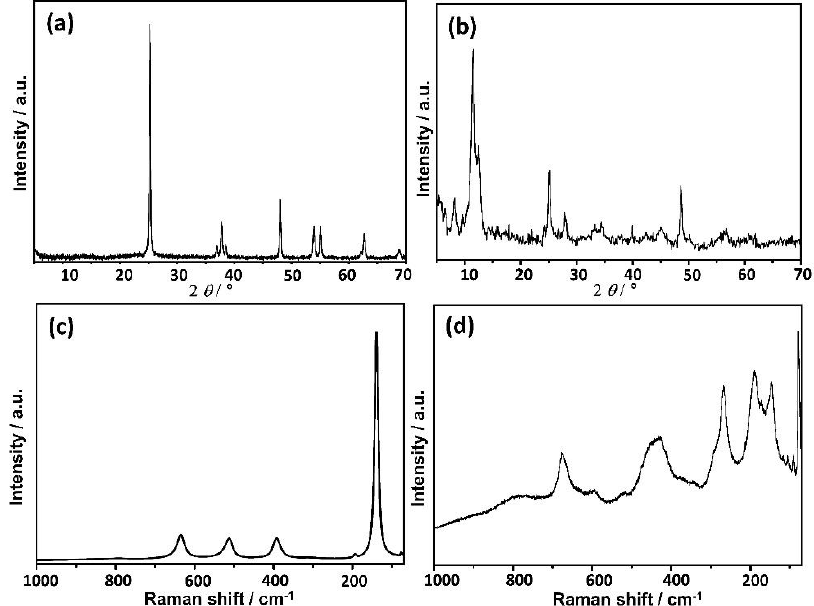
Figure 1. Powder X-ray diffraction (PXRD) patterns ( a , b ) and Raman spectra ( c , d ) of synthesized TiO 2 nanoplates ( a , c ) and nanowires ( b , d ).